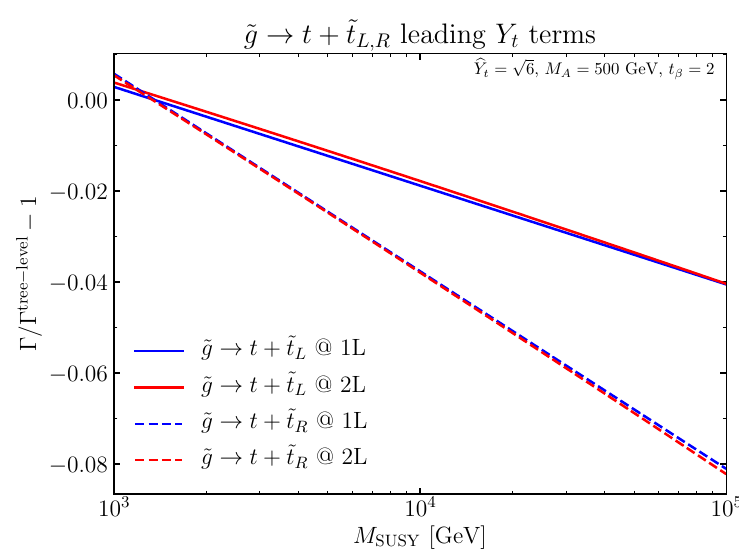
Figure 11. The gluino decay widths ˜ g → t + ˜ t L,R as a function of M SUSY , where the final state t + ˜ t L is displayed by the solid curves and t + ˜ t R by the dashed curves. The one-loop results including all corrections in leading powers of Y t are shown relative to the tree-level decay width by the blue curves, while the corresponding two-loop results are displayed by the red